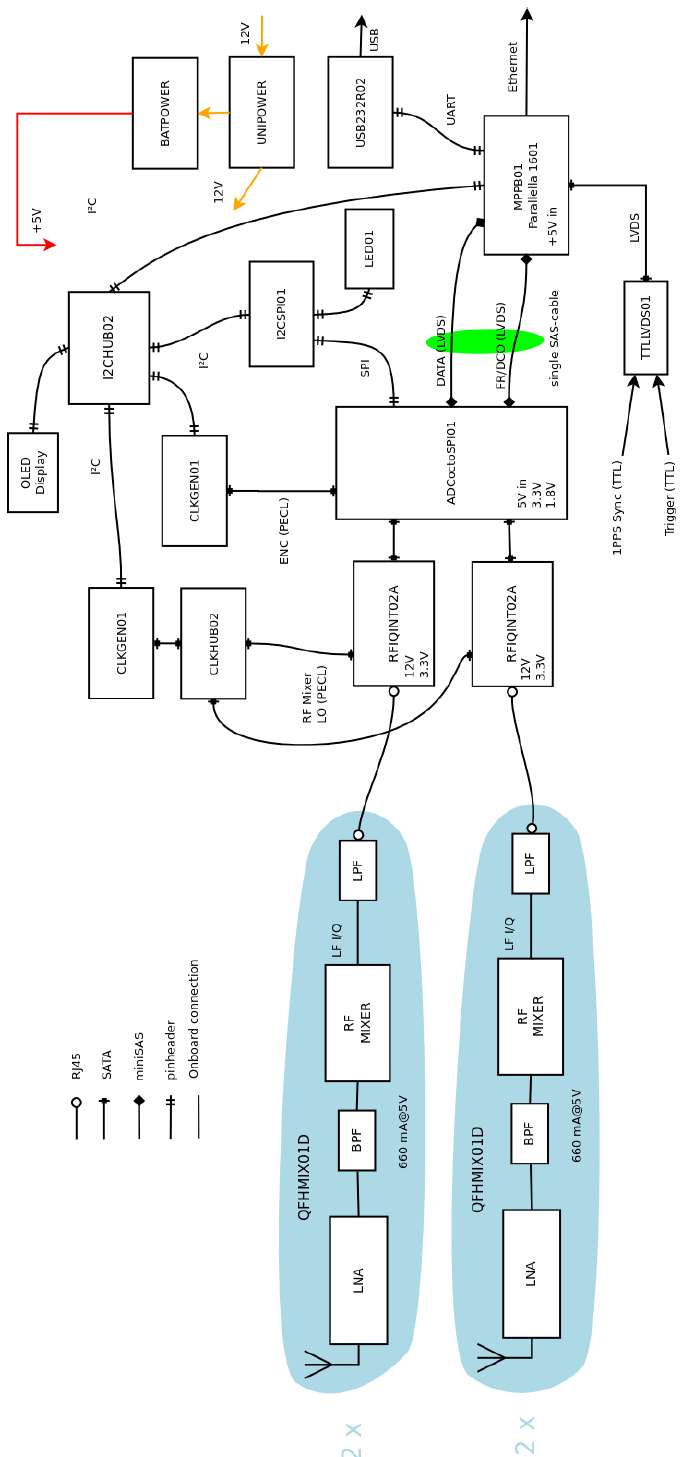
Figure A1. Block diagram of the UHF radio receiver used in the experiment. The internals of the active antenna mounted on the car roof are depicted using the blue bubbles on the